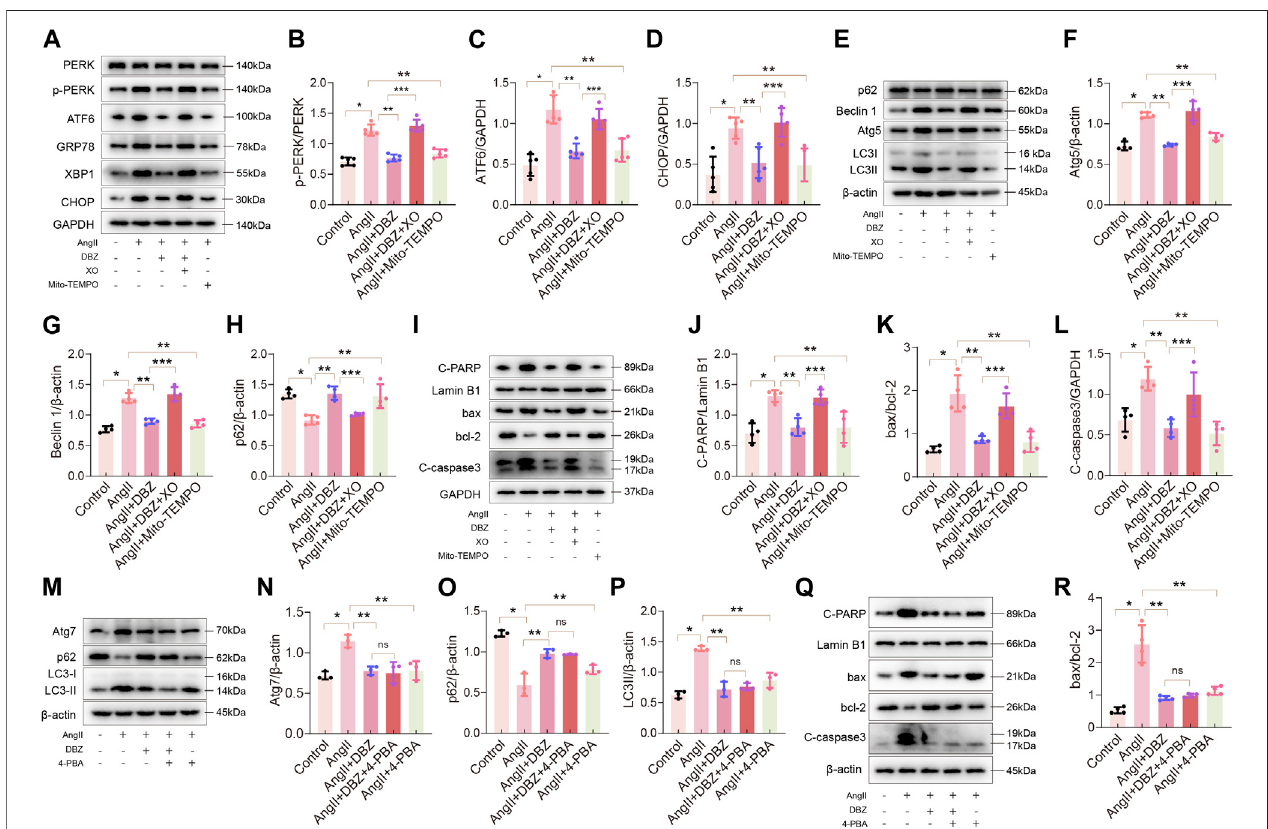
FIGURE 7 | Oxidative stress contributed to ER stress, autophagy and apoptosis. (A – D) Representative Western blotting assay and quanti fi cation of PERK, p-PERK, ATF6, CHOP, GRP78 and XBP1 expression. n = 4 – 5. (E – H) Representative Western blotting assay and quanti fi cation of Atg5, Beclin1, p62 and LC3 expression. n = 4. (I – L) Representative Western blotting assay and quanti fi cation of C-PARP, bax, bcl-2 and C-caspase3 expression. n = 4. (M – P) Representative Westernblottingassayandquanti fi cationofAtg7,p62andLC3expression. n =3. (Q – R) RepresentativeWesternblottingassayandquanti fi cationofC-PARP,bax, bcl-2andC-caspase3expression. n =4.* p < .05comparedwiththeControlgroup,** p < .05comparedwiththeAngIIgroup,*** p < .05comparedwiththeAngII+DBZ group. Results are expressed as means ± SD. Statistical analyses were performed by one-way ANOVA followed by Bonferroni ’ s post-hoc